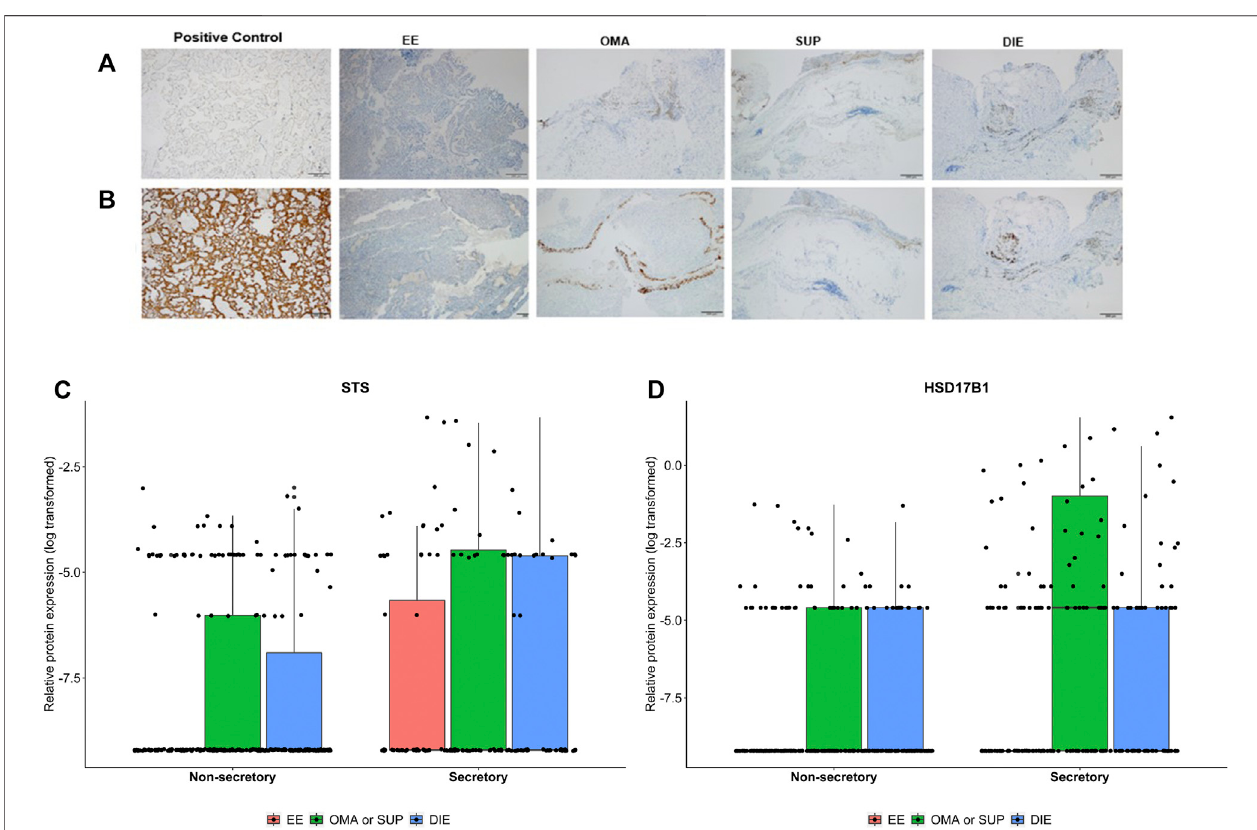
FIGURE 5 | Representative images from STS (A) and HSD17B1 (B) protein expression in endometriotic samples and positive control (placenta) analyzed by immunohistochemistry. Protein tissue expression levels of STS (C) and HSD17B1 (D) in eutopic endometrium from endometriosis patients (EE), ovarian (OMA), super fi cial(SUP),anddeep-in fi ltrating(DIE)lesions.Samplesweredividedintoanonsecretoryandsecretoryphaseofthemenstrualcycle.Barsrepresentthelog 10 mean fold change of the relative protein expression, accompanied by the 95%